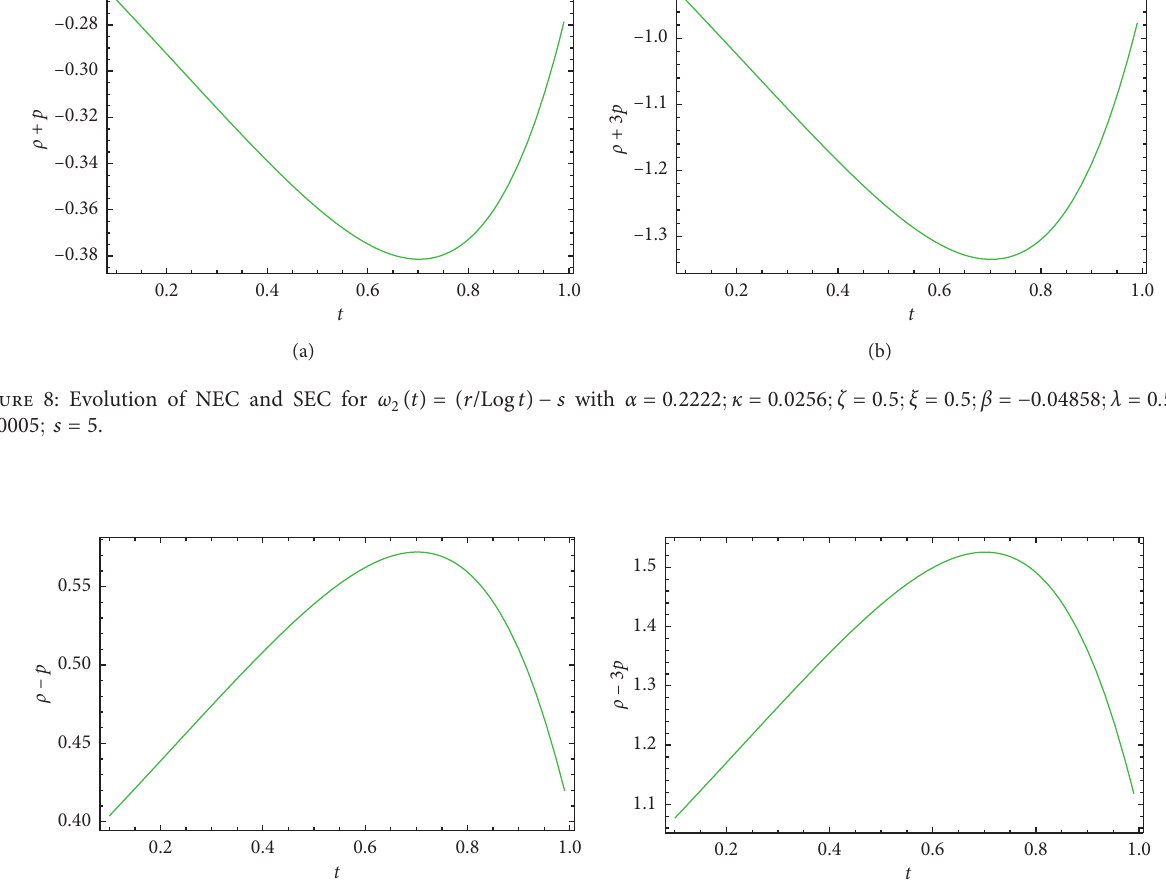
( t ) � ( r /Log t ) − s with α � 0 . 2222 ; κ � 0 . 0256 ; ζ � 0 . 5 ; ξ � 0 . 5 ; β � − 0 . 04858 ; λ � 0 . 5 ; r � 2